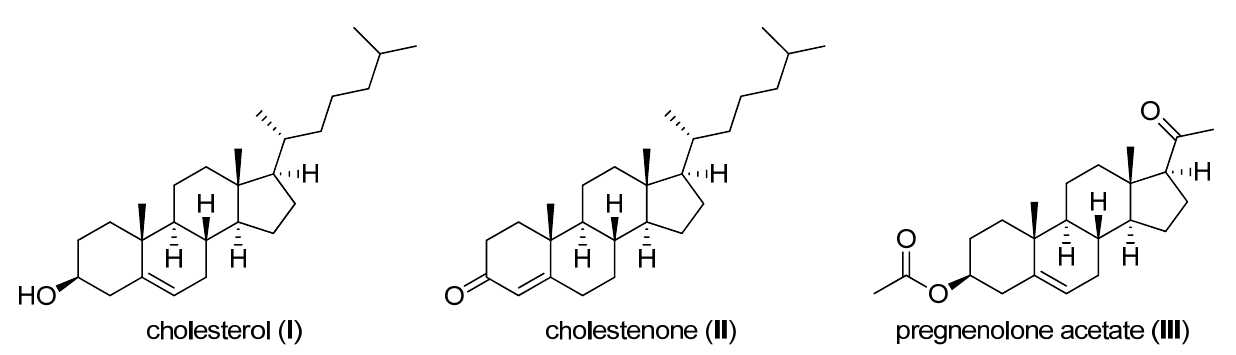
Figure 1. Structures of model